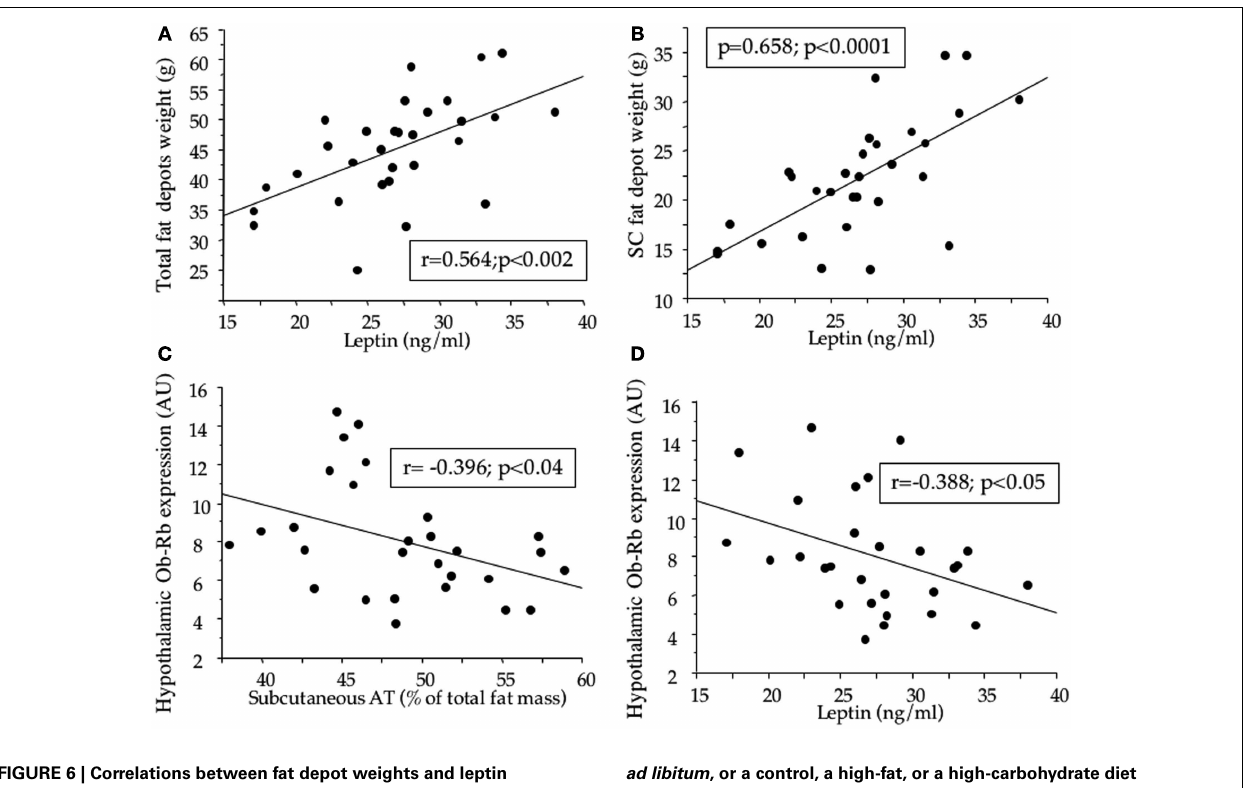
FIGURE 6 | Correlations between fat depot weights and leptin (A,B), fat depot weight and hypothalamic leptin receptor (Ob-Rb) expression (C), and Ob-Rb expression and leptin (D) in adult offspring from dams fed during gestation either a control diet